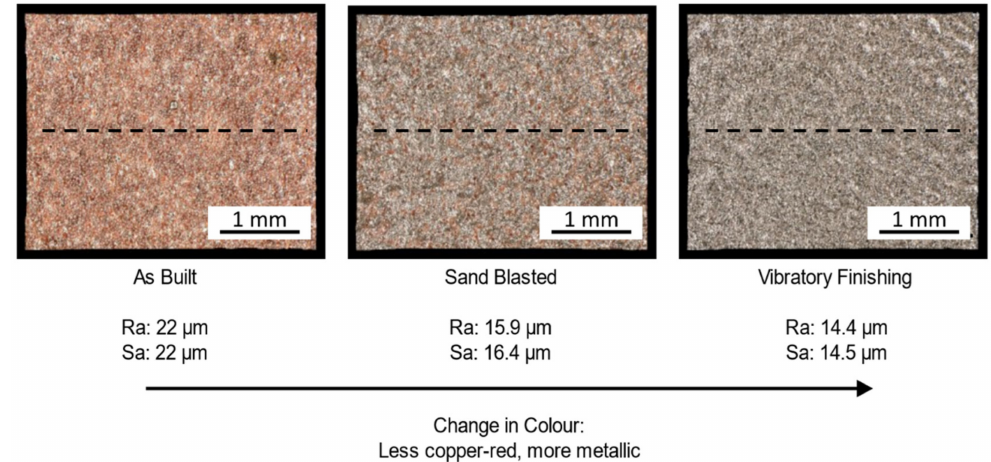
Figure 6. Post-processed Cu samples and the respective surface roughness. The dashed line indicates the line scans.